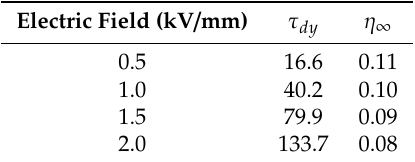
Figure 4. Shear rate-dependent ( a ) shear stress and ( b ) shear viscosity curves of PDPA / Fe 3 O 4 -based ER fluid (10 vol%, 50 cSt silicone oil) under different electric field strengths. Table 1. Fitted parameters of Bingham model for PDPA / Fe 3 O 4 -based ER fluid (10 vol%, 50 cSt silicone oil).